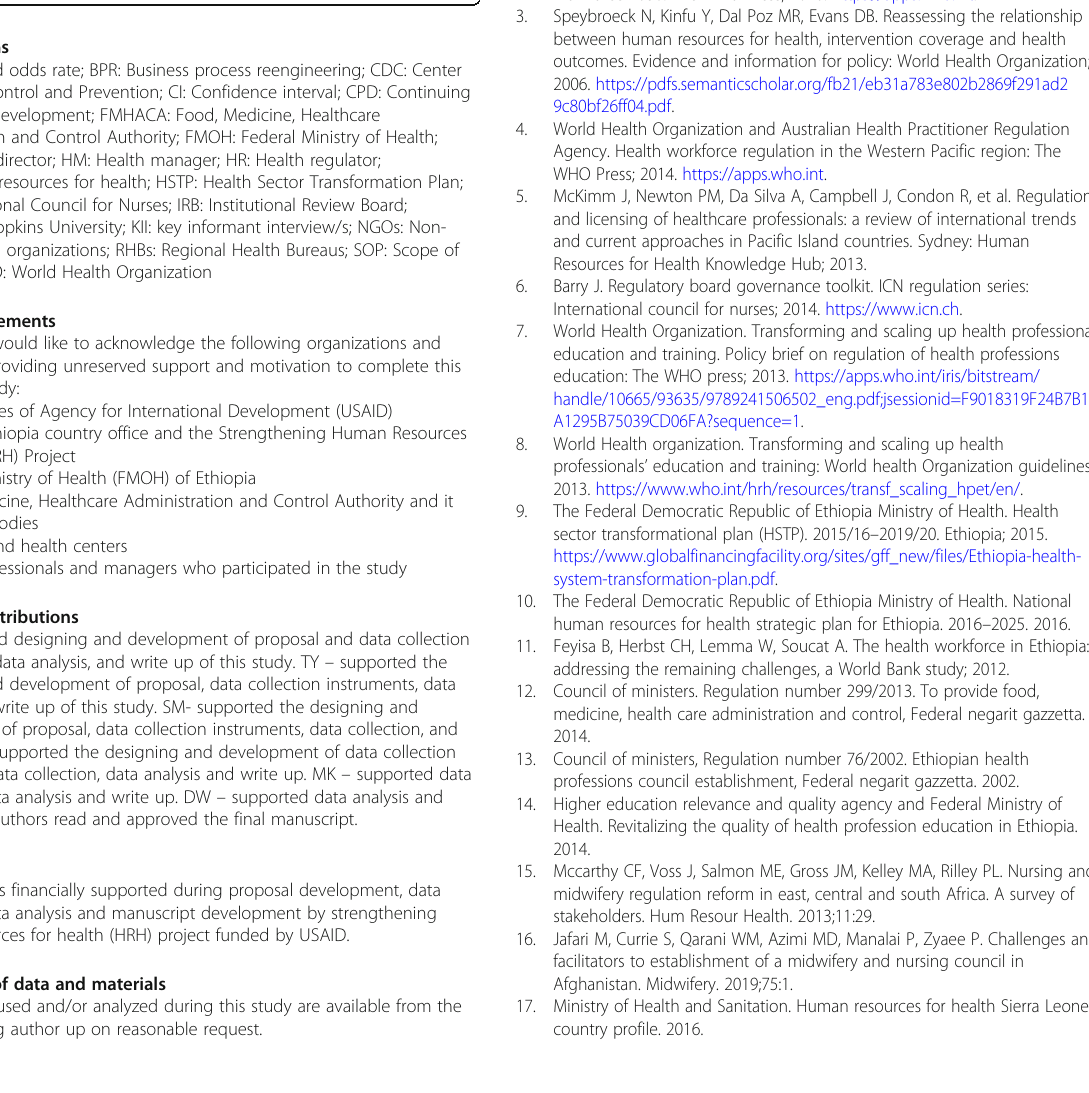
Additional file 1: Table S1. Experiences on CPD, exploring health workforce regulation practices and gaps, Ethiopia, March 2015. Abbreviations AOR: Adjusted odds rate; BPR: Business process reengineering; CDC: Center for Disease Control and Prevention; CI: Confidence interval; CPD: